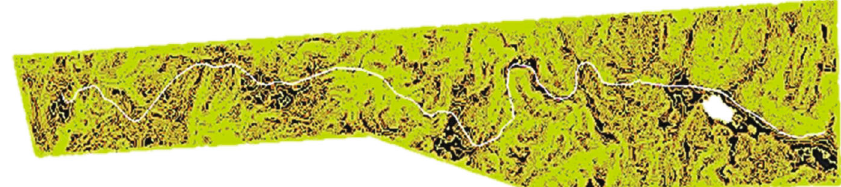
Figure 2: Nablus-Ramallah geography and topography plan.